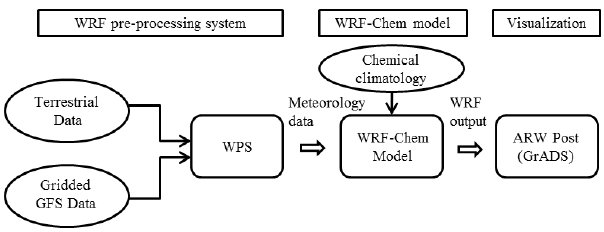
Figure A1. Flowchart of the WRF-Chem model.